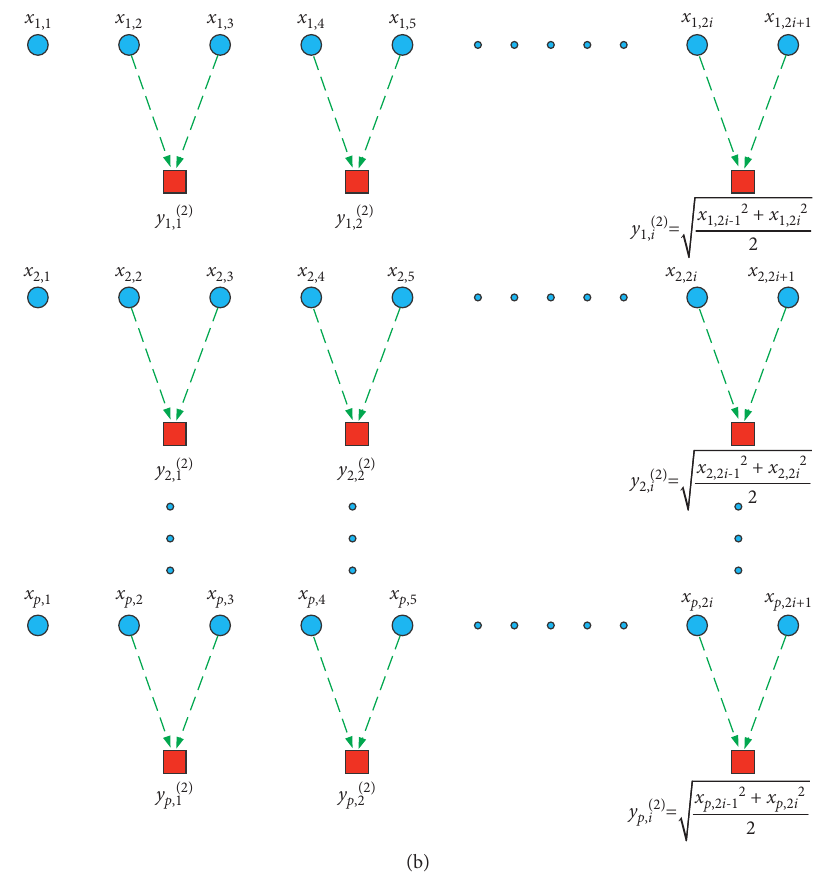
Figure 3: Illustration of refined composite coarse-grained approach for multivariate time series with scale factor 2. (a) First coarse-grained time series; (b) second coarse-grained time series. Figure is reproduced from Fuming Zhou 2020.